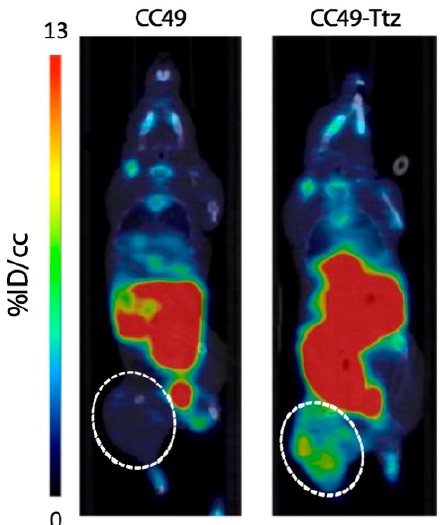
Figure 4. ( A ) In vivo plasma metabolites and ( B ) biodistribution of [ 18 F]F-MICA-205 in healthy Balb/C mice at 1 h post injection [86].